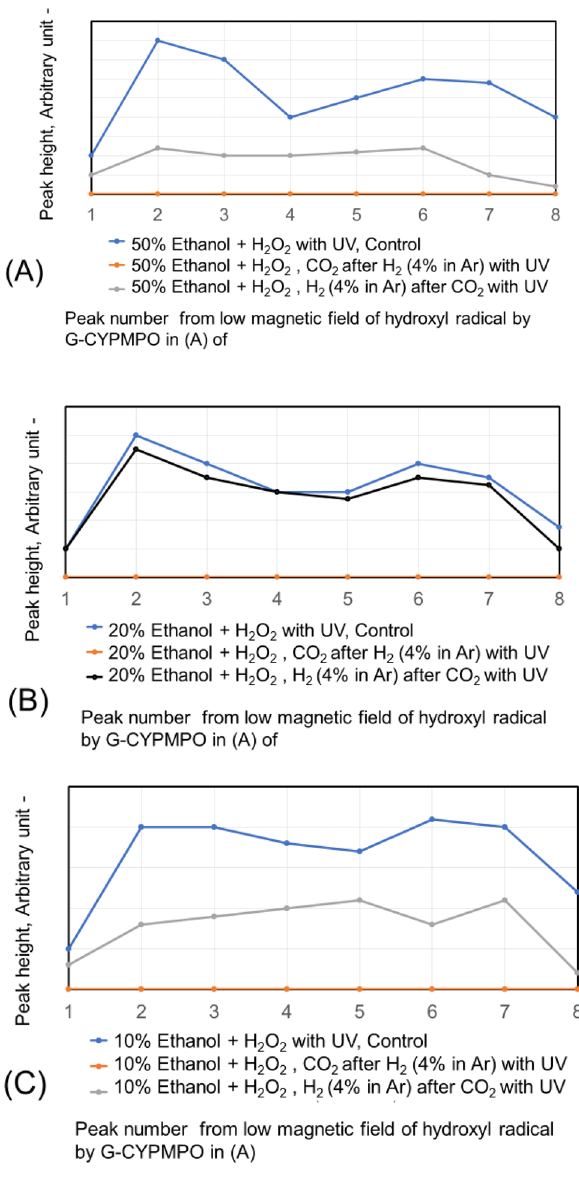
Figure 6. Peaks of hydroxyl radical with ESR by blowing CO 2 after H 2 (4% in Ar) gas nanobubble and H 2 (4% in Ar) after